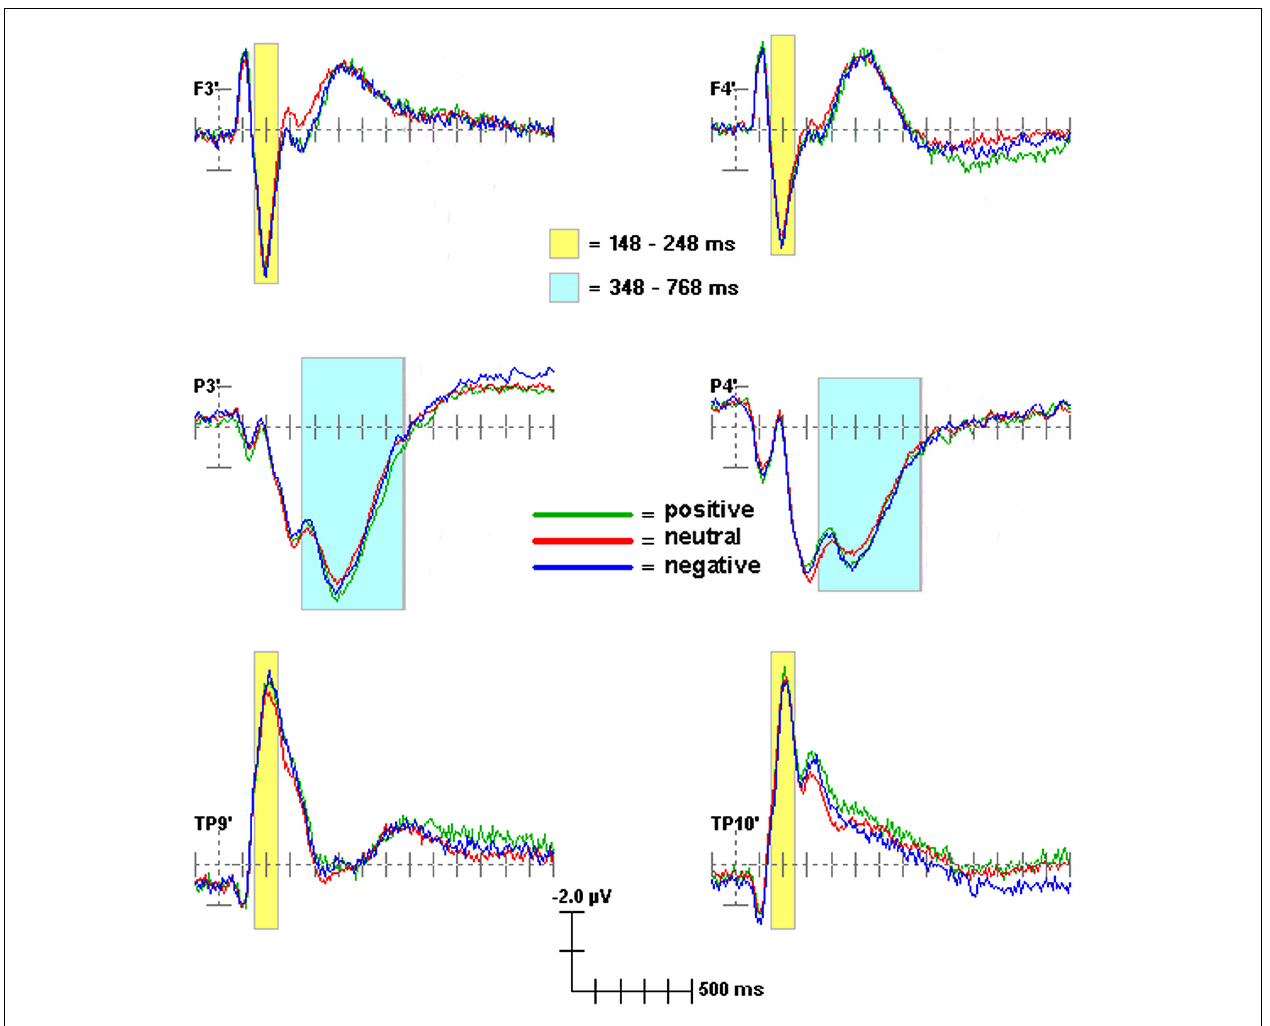
FIGURE 1 | ERP scoring windows illustrated for representative channels. All channels relative to an average reference.Waveforms from 100 ms prior to stimulus onset to 1400 ms after stimulus onset. Each tick mark on the x-axis represents 100 ms.The apostrophes after the channel names indicate that the channel locations were